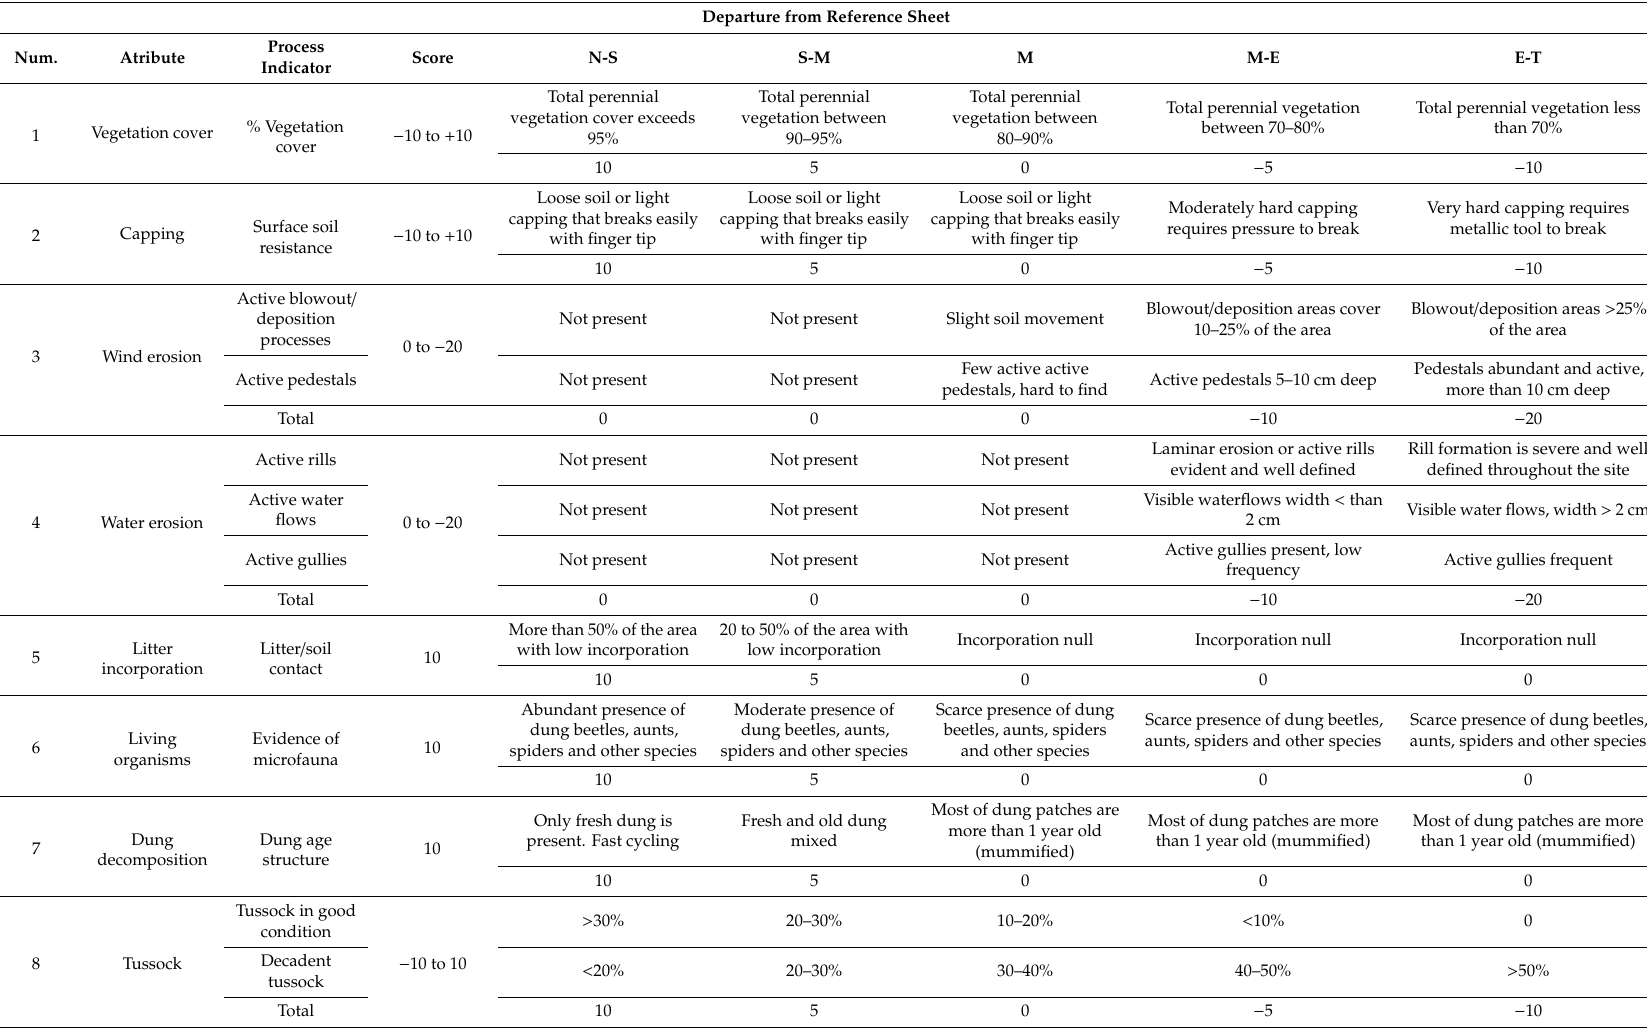
Table A1. Evaluation Matrix (Humid Magellan Steppe